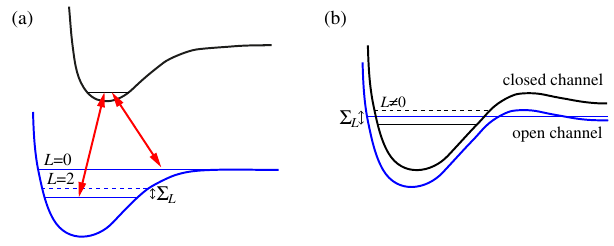
FIG. 4. Detection of the angulon self-energy Σ using (a) photo- L association spectroscopy [38] and (b) shift of p - and d -wave Feshbach resonances